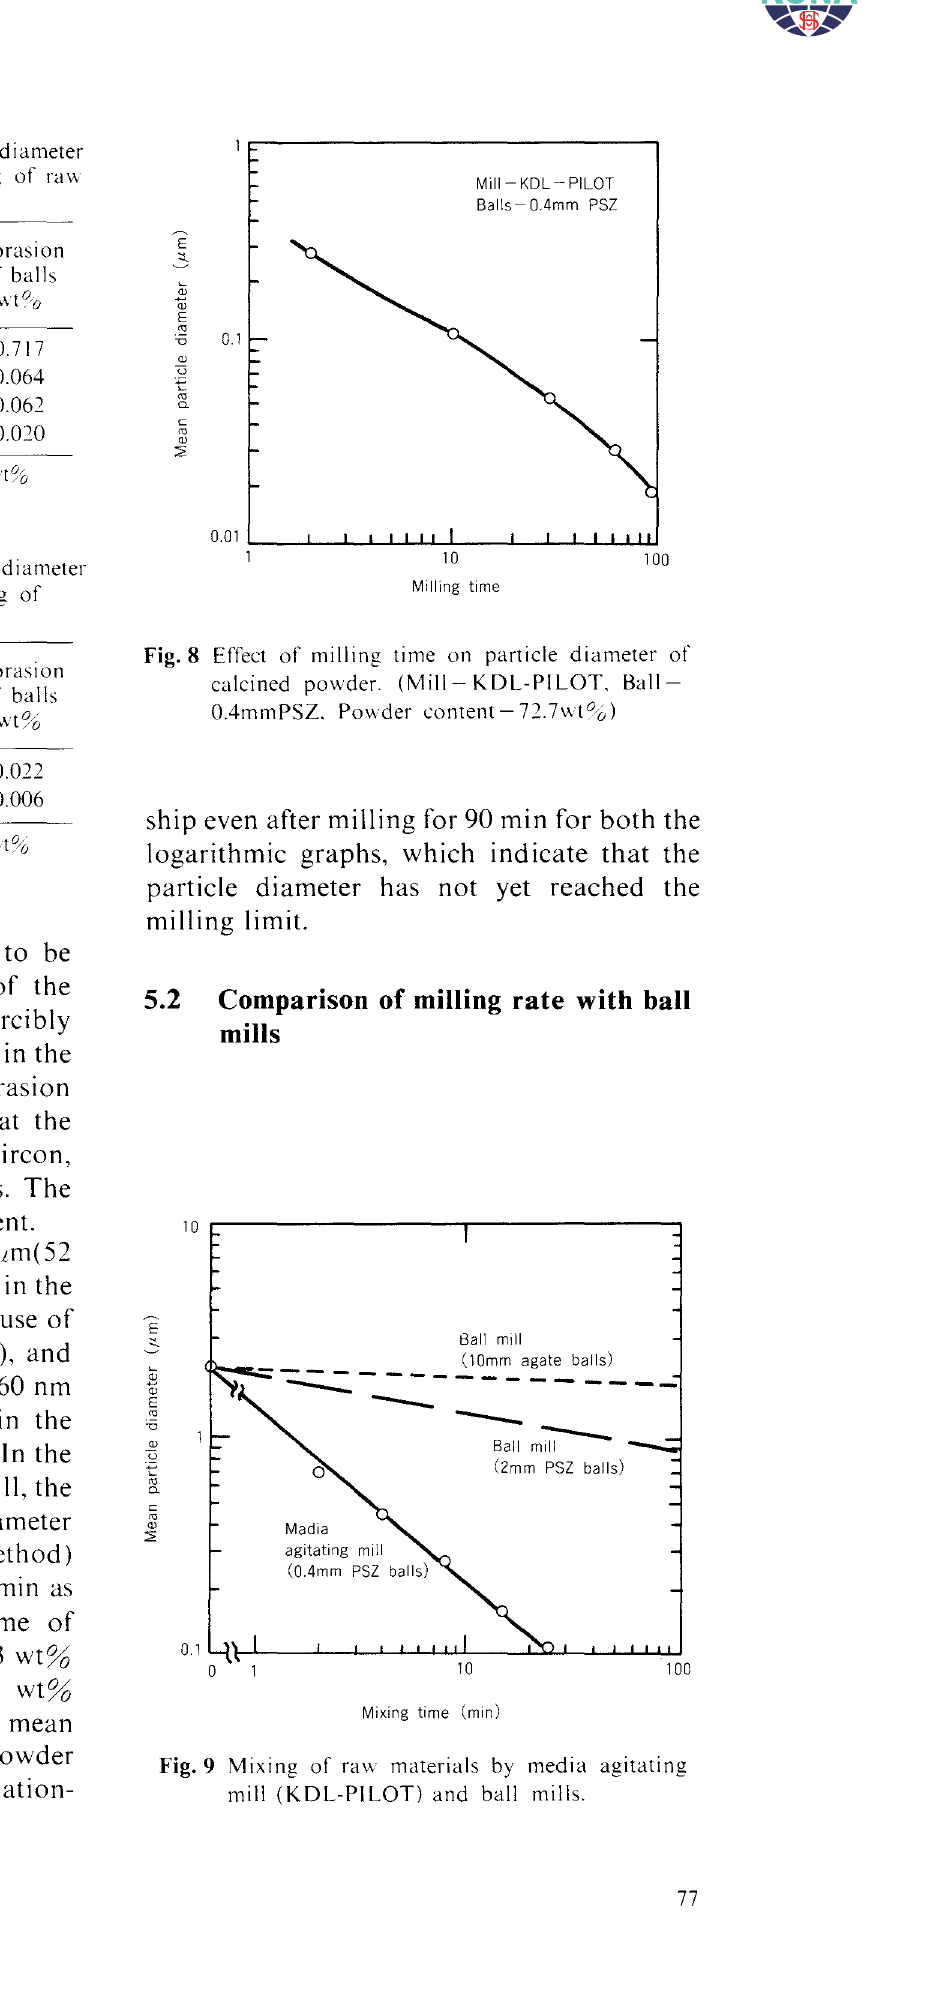
Fig. 9 Mixing of rav. materials by media agitating mill (KDL-PILOT) and ball